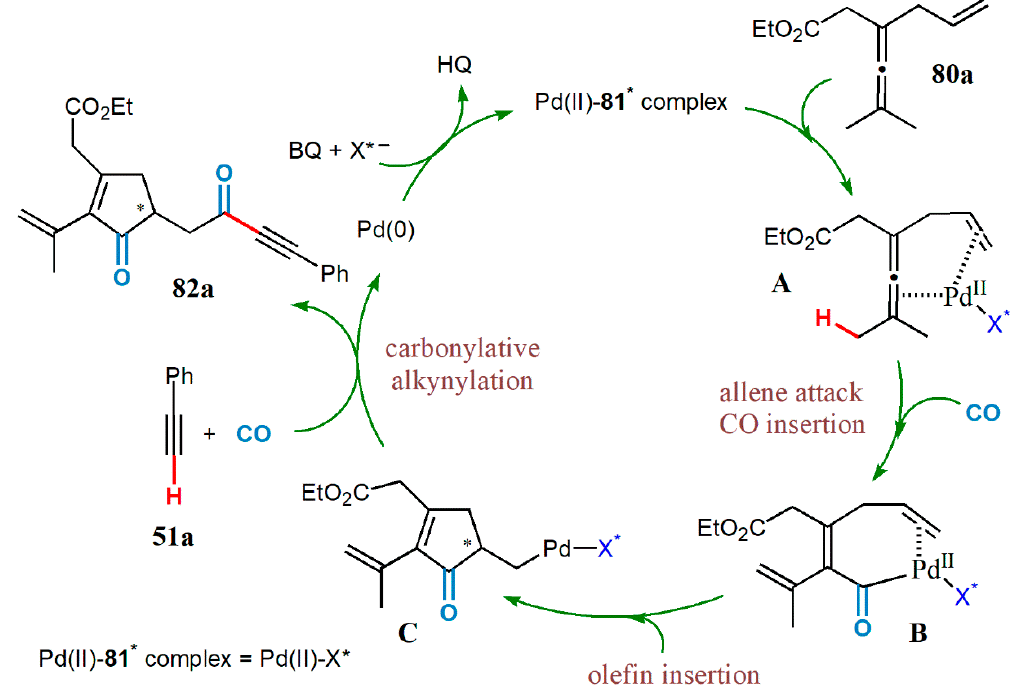
Figure 25. The mechanism proposed for the carbonylative carbocyclization of enallenes via CDC with alkynes.